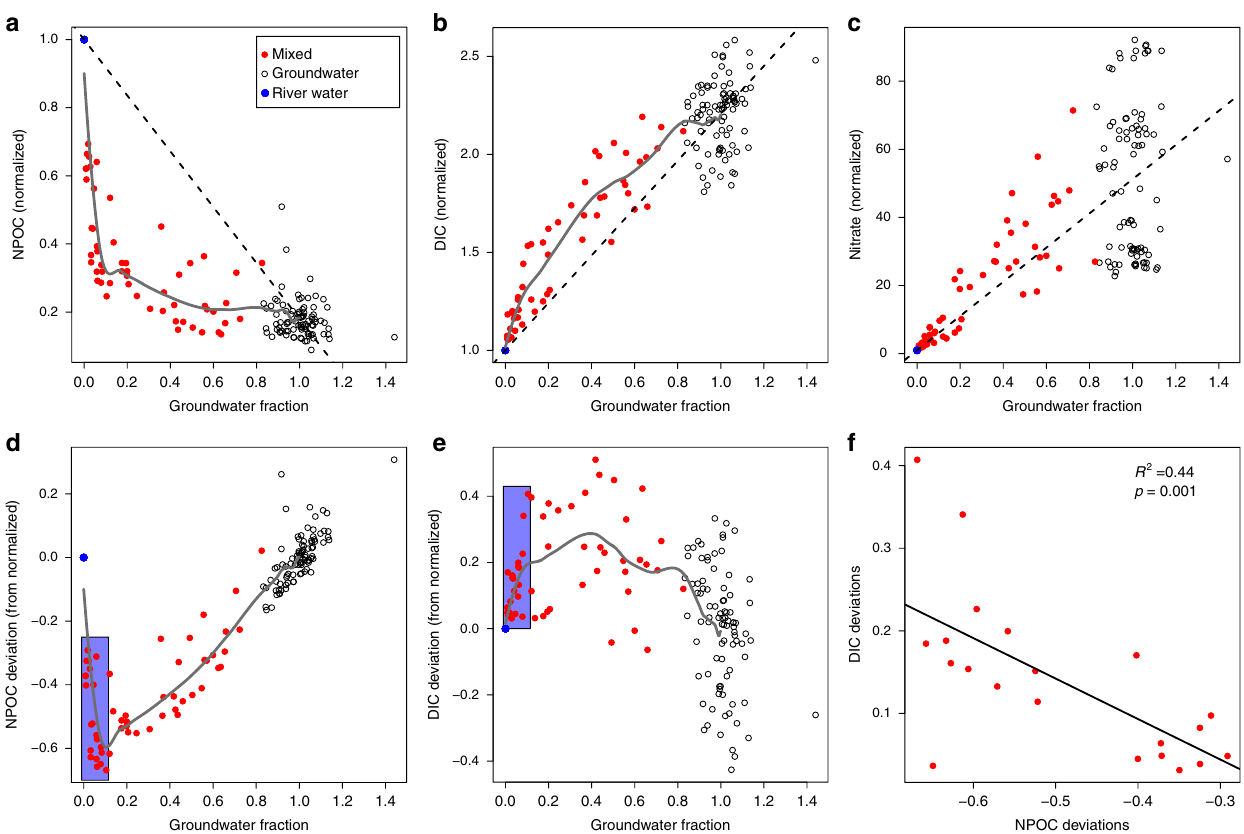
Fig. 3 Reactive solutes and groundwater fraction and mixing model deviations. a – c Reactive solutes as functions of groundwater (GW) fraction inferred using Cl – as a conservative tracer. Linear mixing model expectations are indicated by dashed lines; gray lines are spline fi ts. River water (RW) concentrations of reactive solutes varied through time. Concentrations at each point in time were thus normalized to the associated RW concentrations; RW samples (blue circles) are always at 1 on the vertical axes. Cl − concentrations varied across GW wells (open circles) such that a threshold concentration was selected to indicate pure GW; non-river samples with Cl − concentration below this threshold were considered mixed (red circles). DOC, dissovled organic carbon; DIC, dissolved inorganic carbon. d , e Deviations from the DOC and DIC mixing models as functions of GW fraction. The purple rectangles on both panels indicate the range of conditions across which DOC deviations become increasingly negative. f DIC and DOC mixing model deviations within the purple rectangles are regressed on each other, revealing a signi fi cant negative relationship; the solid line is the regression model and statistics are provided on the